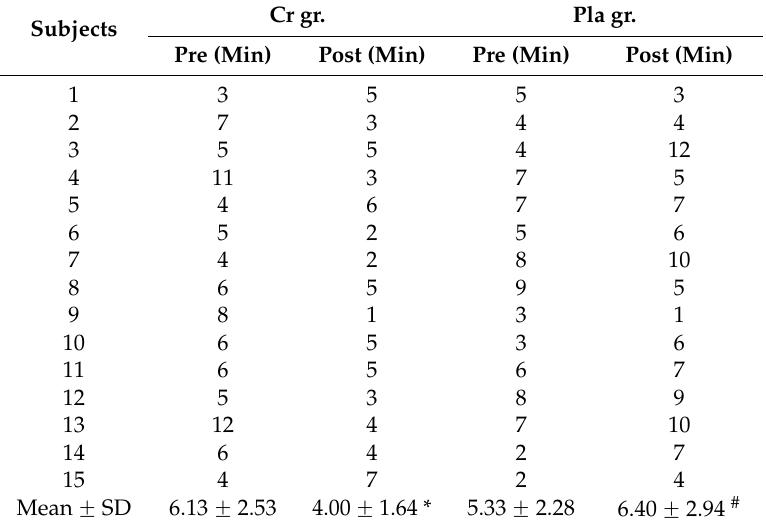
Table 2. Optimal individual postactivation potentiation (PAP) time for each subjects following creatine or placebo supplementation. Cr gr. Pla gr. Subjects Pre (Min) Post (Min) Pre (Min) Post